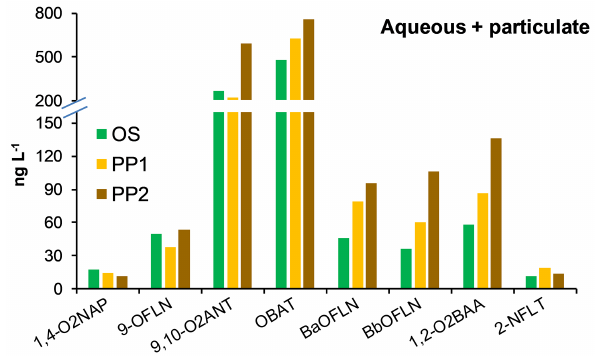
Figure 3. N/OPAHs in snow aqueous + particulate phase; urban and rural.